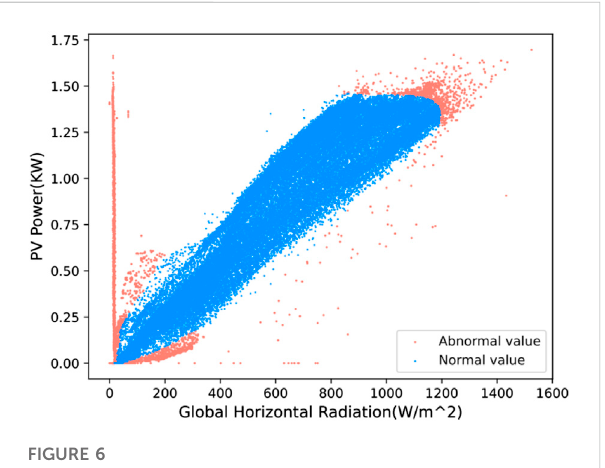
FIGURE 6 Abnormal value detection results of IF